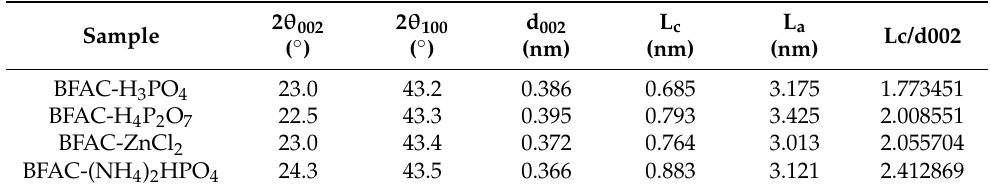
Figure 5. X-ray diffraction patterns of BFACs activated by different activators and BF. Table 2. BFACs crystal structure parameters. (L c ) Gaphite accumulation height, (L c /d 002 ) number of graphite stacking layers.